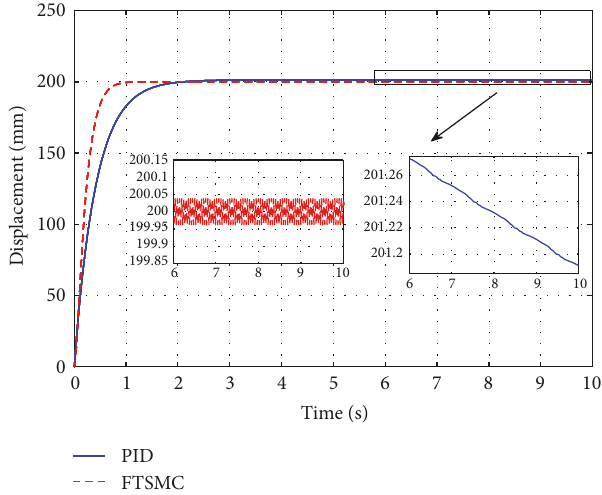
Figure1:Theresponsecurvesfordisplacementunderstepresponse.